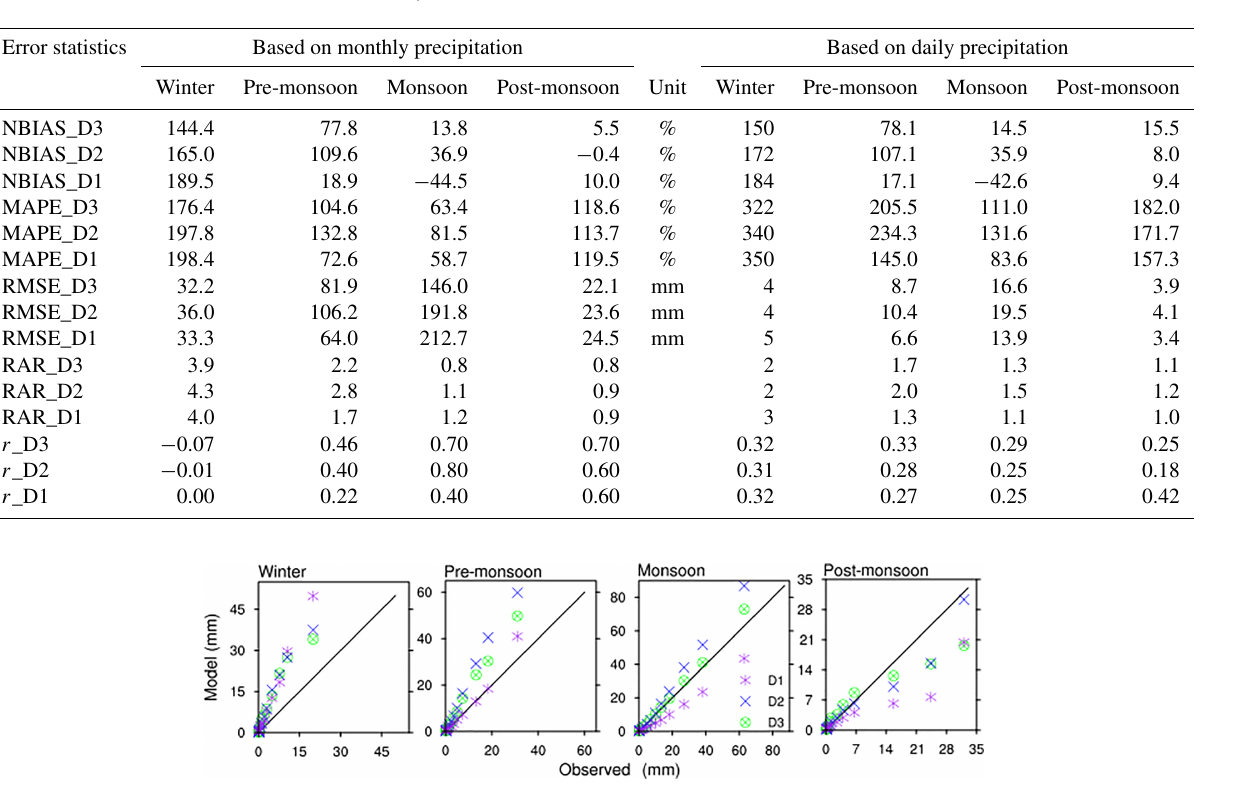
Table 3. Seasonal precipitation error statistics (pooled data) based on monthly and daily precipitation. (D1, D2, and D3 stands for three different domains; NBIAS: normalized bias %; MAPE: mean absolute percentage error; r : correlation; RMSE: root mean squared error; RAR: RMSE/standard deviation of observed data).